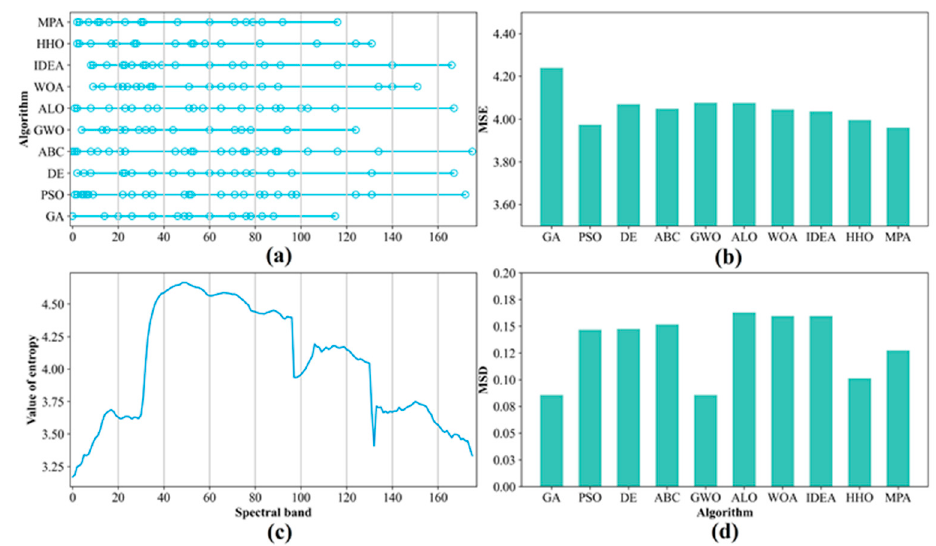
Figure 9. Analysis of the selected bands on the KSC: ( a ) selected bands from the methods, ( b ) MSE value, ( c ) entropy value of each band of the dataset, and ( d ) MSD value.